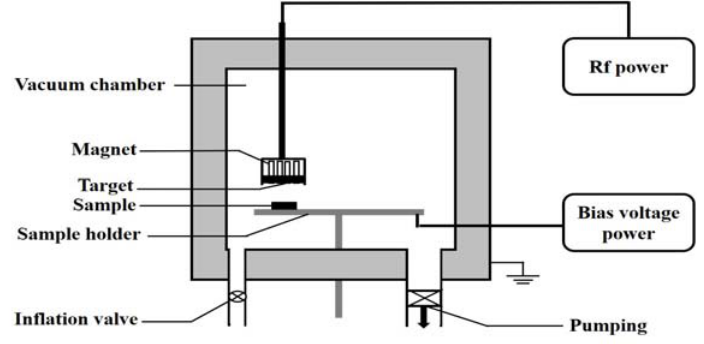
Figure 1. Schematic representation of radio frequency magnetron sputtering system.